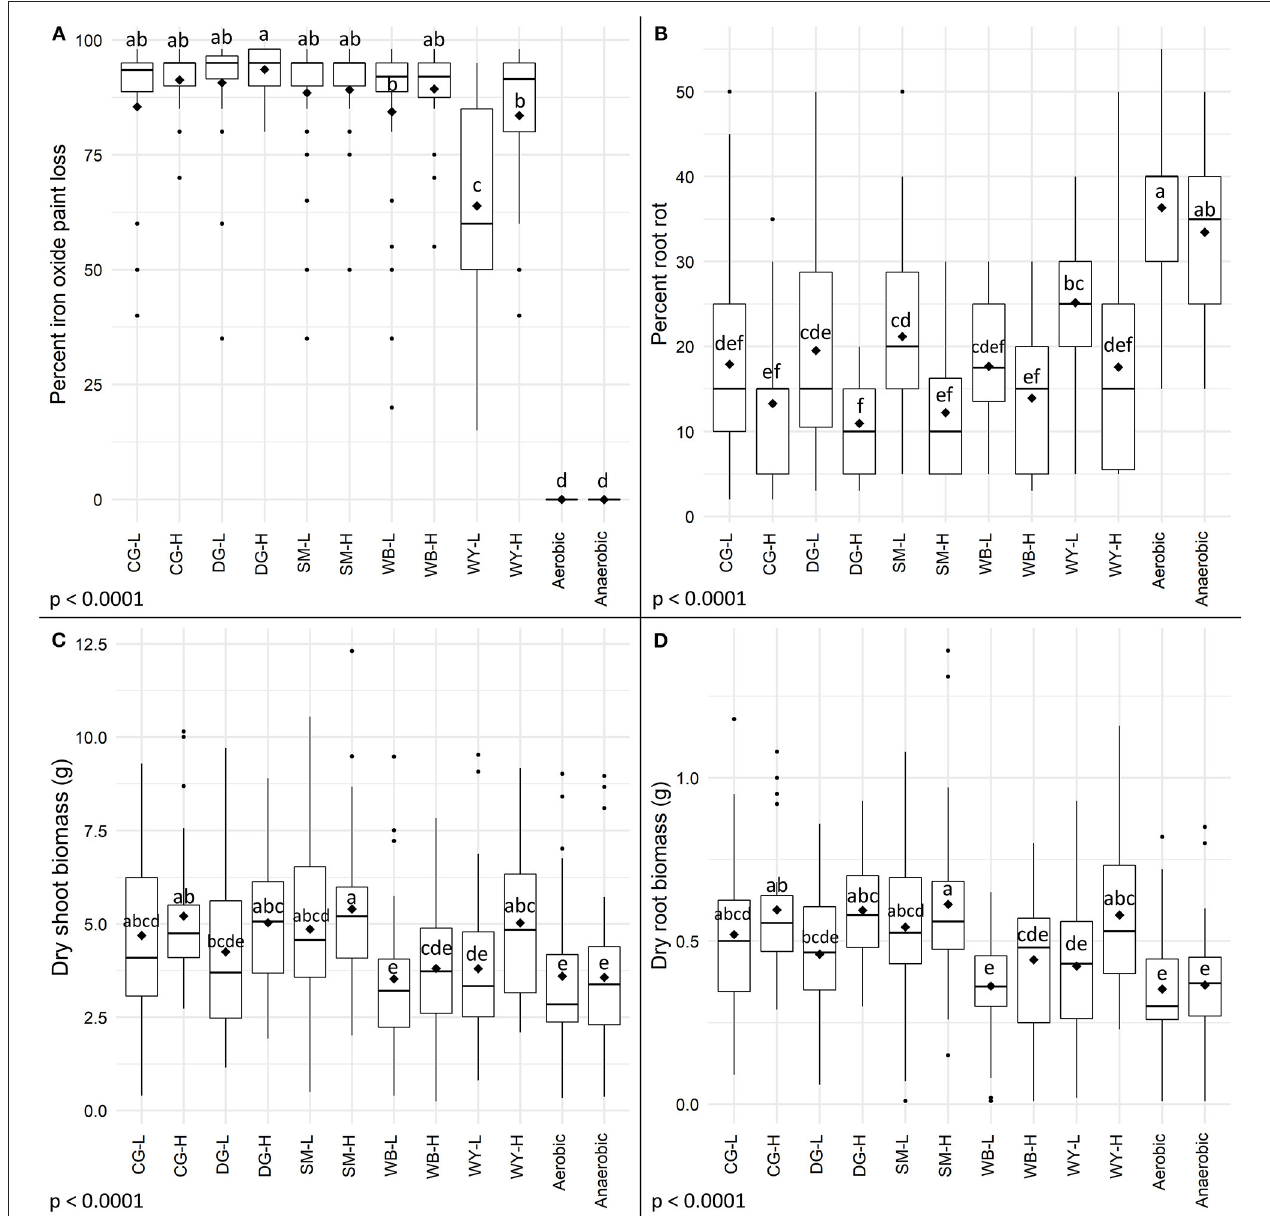
FIGURE 1 | Effects of anaerobic soil disinfestation (ASD) carbon sources and amendment rates on (A) soil reducing conditions as indicated by iron oxide paint loss on IRIS rods, (B) root rot severity, (C) dry shoot biomass, and (D) dry root biomass. Corn gluten meal (CG), distillers dried grains (DG), soybean meal (SM), wheat bran (WB), and dry sweet whey (WY) were evaluated as ASD carbon sources in bioassays at low (L, 10.1 Mg/ha) and high (H, 20.2 Mg/ha) amendment rates and performance was compared to aerobic and anaerobic controls. Treatment means are indicated by diamonds and means that do not share the same letters differ significantly based on Tukey’s HSD with a 95% family-wise confidence